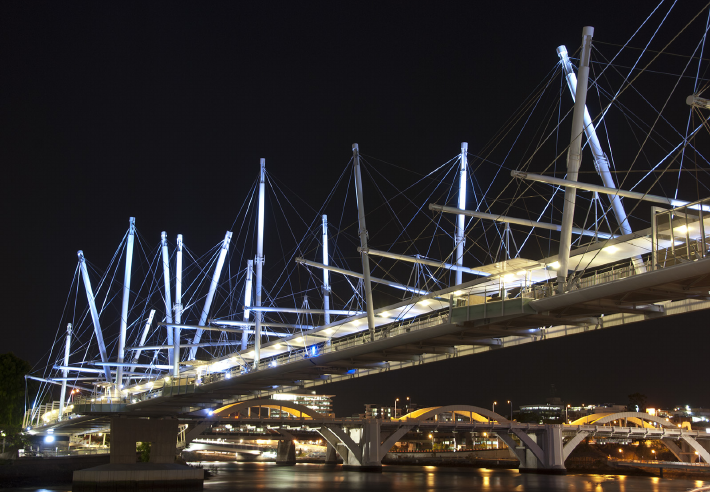
Figure 2. The Kurilpa Bridge in Brisbane, Australia, has a tensegrity structure